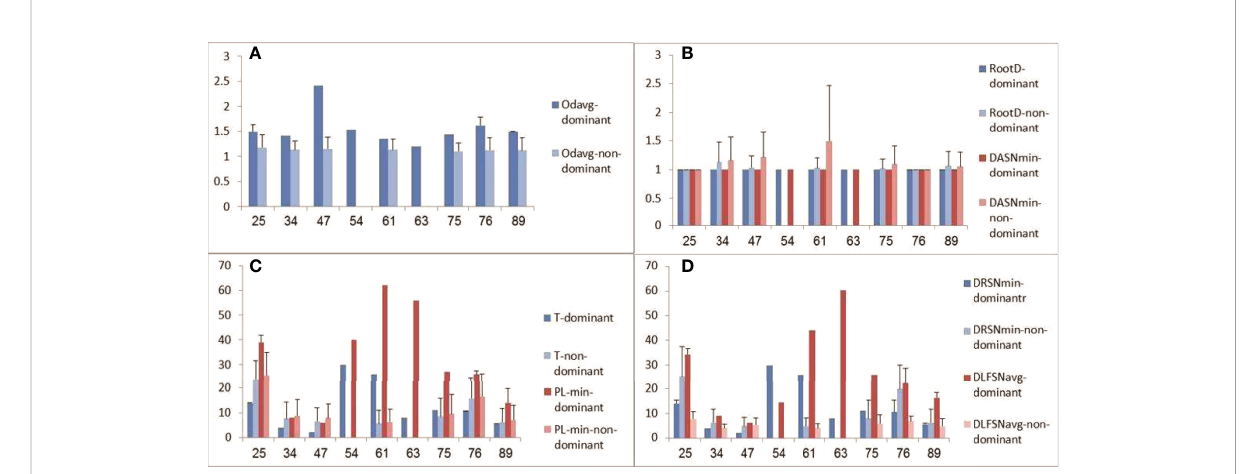
FIGURE 5 Tree measurements of dominant and non-dominant clones. (A) Average outgoing degree (number of children per node); (B) root outgoing degree and minimum distance between adjacent split nodes (DASN-min, or fork-to-fork distance); (C) trunk length (T) and minimum path length (PL-min, from root to a leaf); (D) minimum distance from the root to a split node (DRSN-min) and average trunkless path (distance from a leaf to the fi rst split node on the leaf ’ s path from the root, DLFSN-avg). Patient age is plotted on x-axes, and tree measures (given in numbers of nodes) on y-axes.